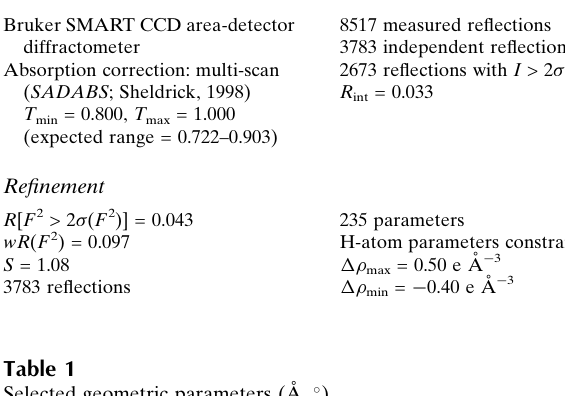
Selected geometric parameters (A˚ , (cid:2)